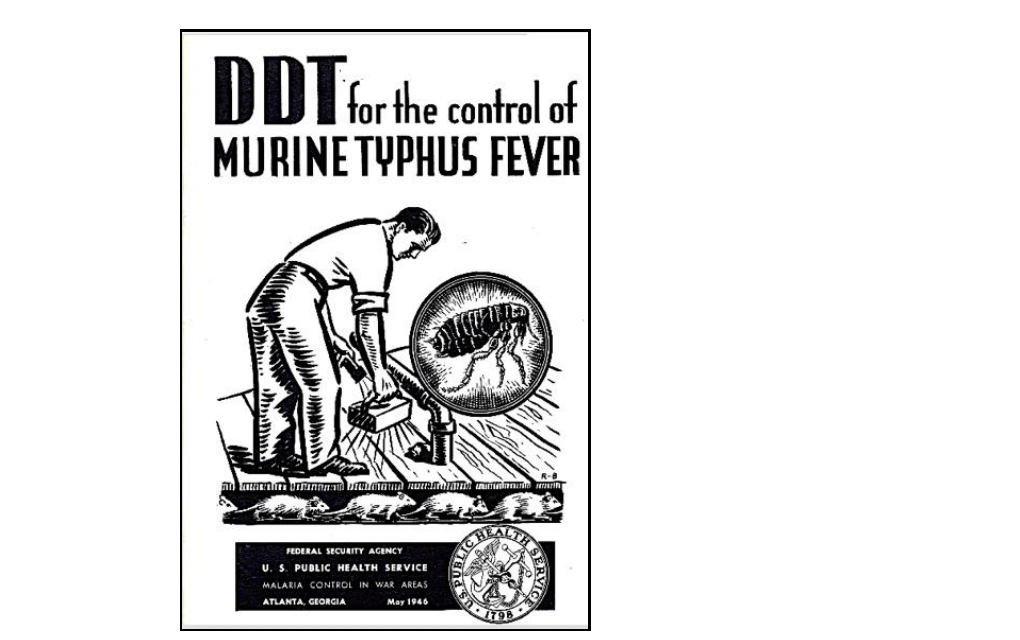
Figure 1. Cover of the 1946 United States Public Health Service pamphlet that first described the use of dichlorodiphenyltrichloroethane (DDT) for flea-borne typhus control [27]. Programs were implemented in 122 of the highest FBT reporting counties in nine southeastern states (Alabama, Florida, Georgia, Louisiana, Mississippi, North Carolina, South Carolina, Tennessee, and Texas) in 1946 and the first half of 1947 (Figures 2 and 3). In 1944, these 122 counties reported 3767 cases, accounting for 71% of all American FBT cases. In 1946, the number of cases had decreased by 51% in 1838. In the ten highest reporting counties, the number of cases fell from 1074 in 1944 to 395 in 1946. In 460 counties not dusted with DDT, FBT cases dropped 7% in 1946, but rebounded 10% in 1947 (see Figure 3 for a comparison of dusted and non-dusted counties). The diminution in FBT cases correlated with a decline in flea populations; based on counts from 17,000 rats, the number of rat fleas dropped 84% in the dusted areas [28]. When the number of fleas per rat was below three, there was little spread of FBT to the human population [29].